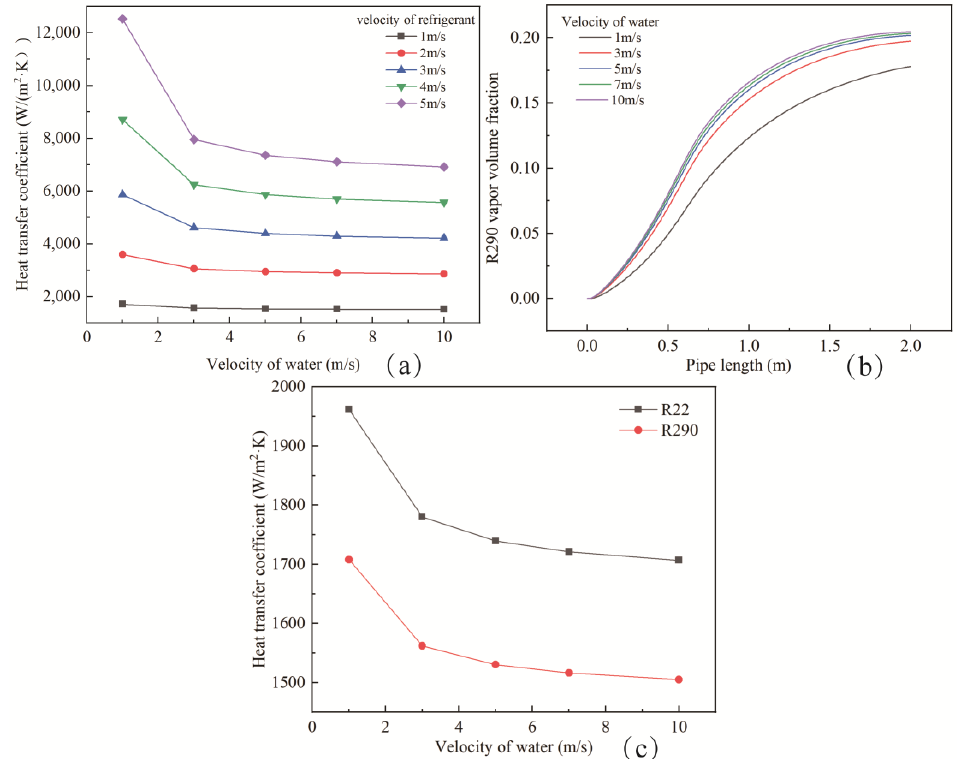
Figure 7. The impact of ( a ) velocity of water on HTC, ( b ) R290 volume fraction at the innertube wall surface and ( c ) HTC for R22 and R290 at different water velocities.